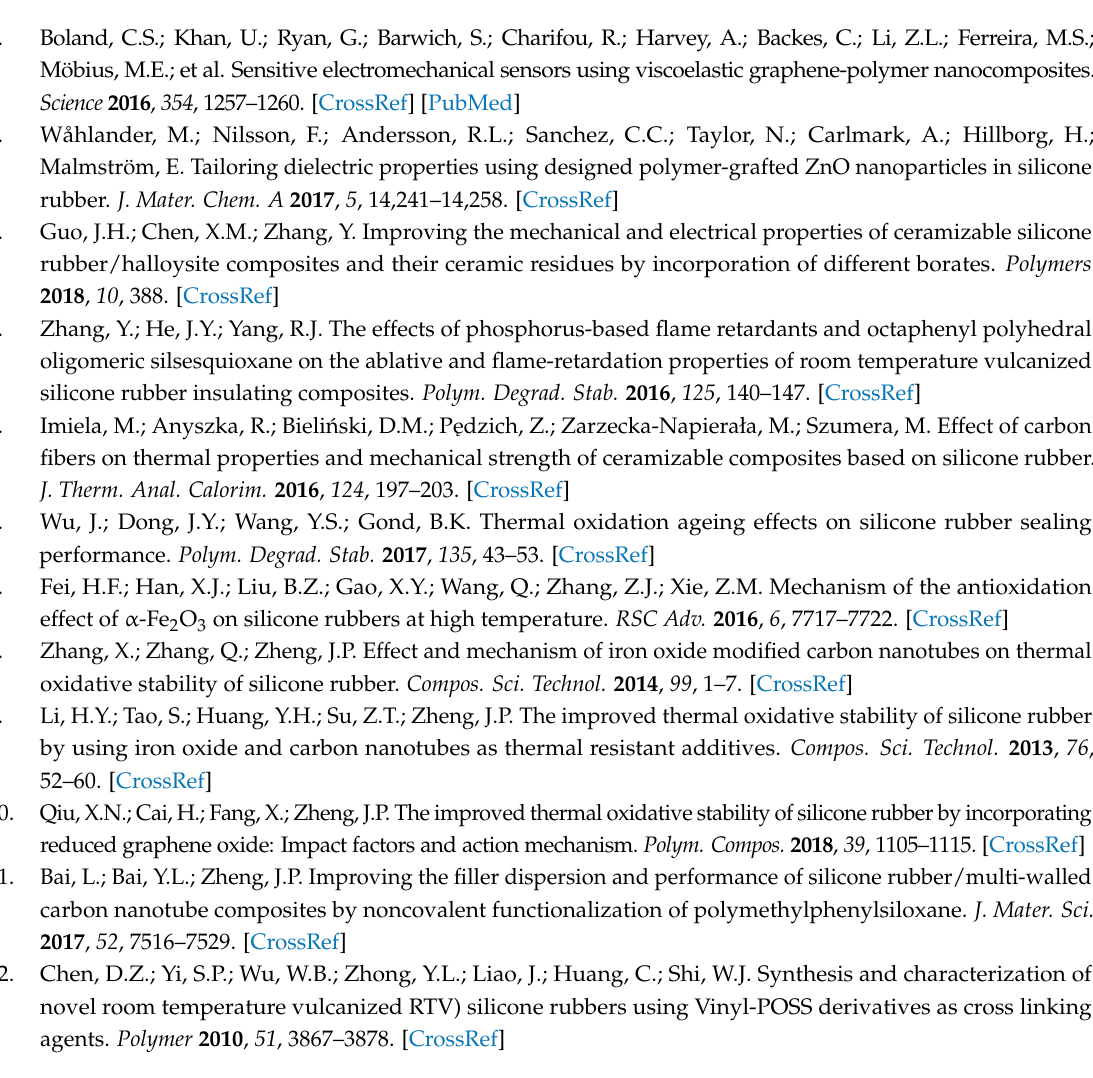
Table S1: Effect of Zr-POSS on the curing characteristics of SR, Table S2: Characteristic data obtained from TGA and DTG curves (nitrogen, 20 ◦ C/min), Figure S1: UV-Vis spectra of SR/Zr-POSS nanocomposites, Figure S2: TGA and DTG curves of SR/Zr-POSS nanocomposites under nitrogen atmosphere, Figure S3: 3D TG-FTIR and FTIR spectra of pyrolysis products for SR (a) and SR/Zr-POSS-4 nanocomposites (b) under nitrogen atmosphere, Figure S4: FTIR absorbance evolution of the pyrolysis products during thermal degradation for SR and SR/Zr-POSS-4 nanocomposites under nitrogen atmosphere, Figure S5: 29 Si NMR spectra of SR (a) and SR/Zr-POSS-4 nanocomposites (b) before and after